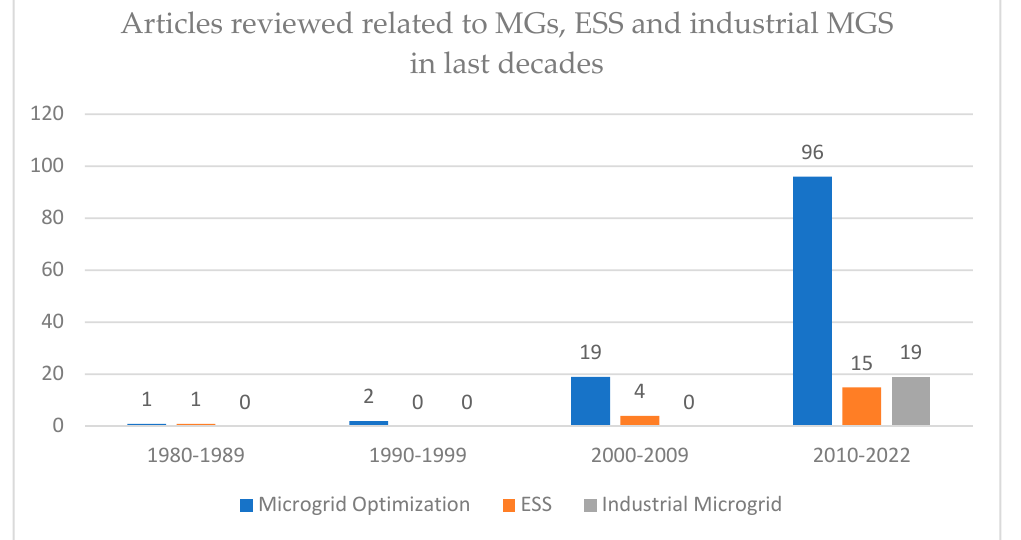
Figure 3. Possible trends and future research path regarding industrial MGs (source: own elabora- tion).